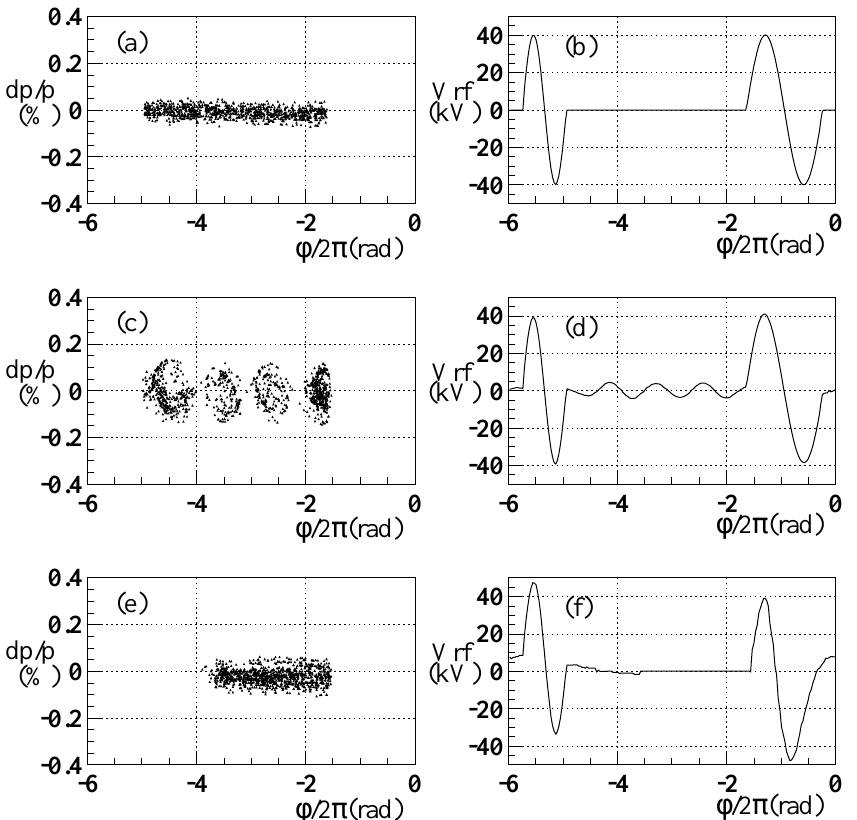
FIG. 16. Phase-space configurations: (a),(c),(e) momentum spreads; (b),(d),(f) rf voltages. (a),(b) ideal state; (c),(d) with the beam loading by the ferrite cavity; (e),(f) with the overshooting voltage of the MA cavity. The sweep time is 100 ms. The horizontal axis is rf phase. The beam intensity is 7 3 10 12 protons (cid:1)